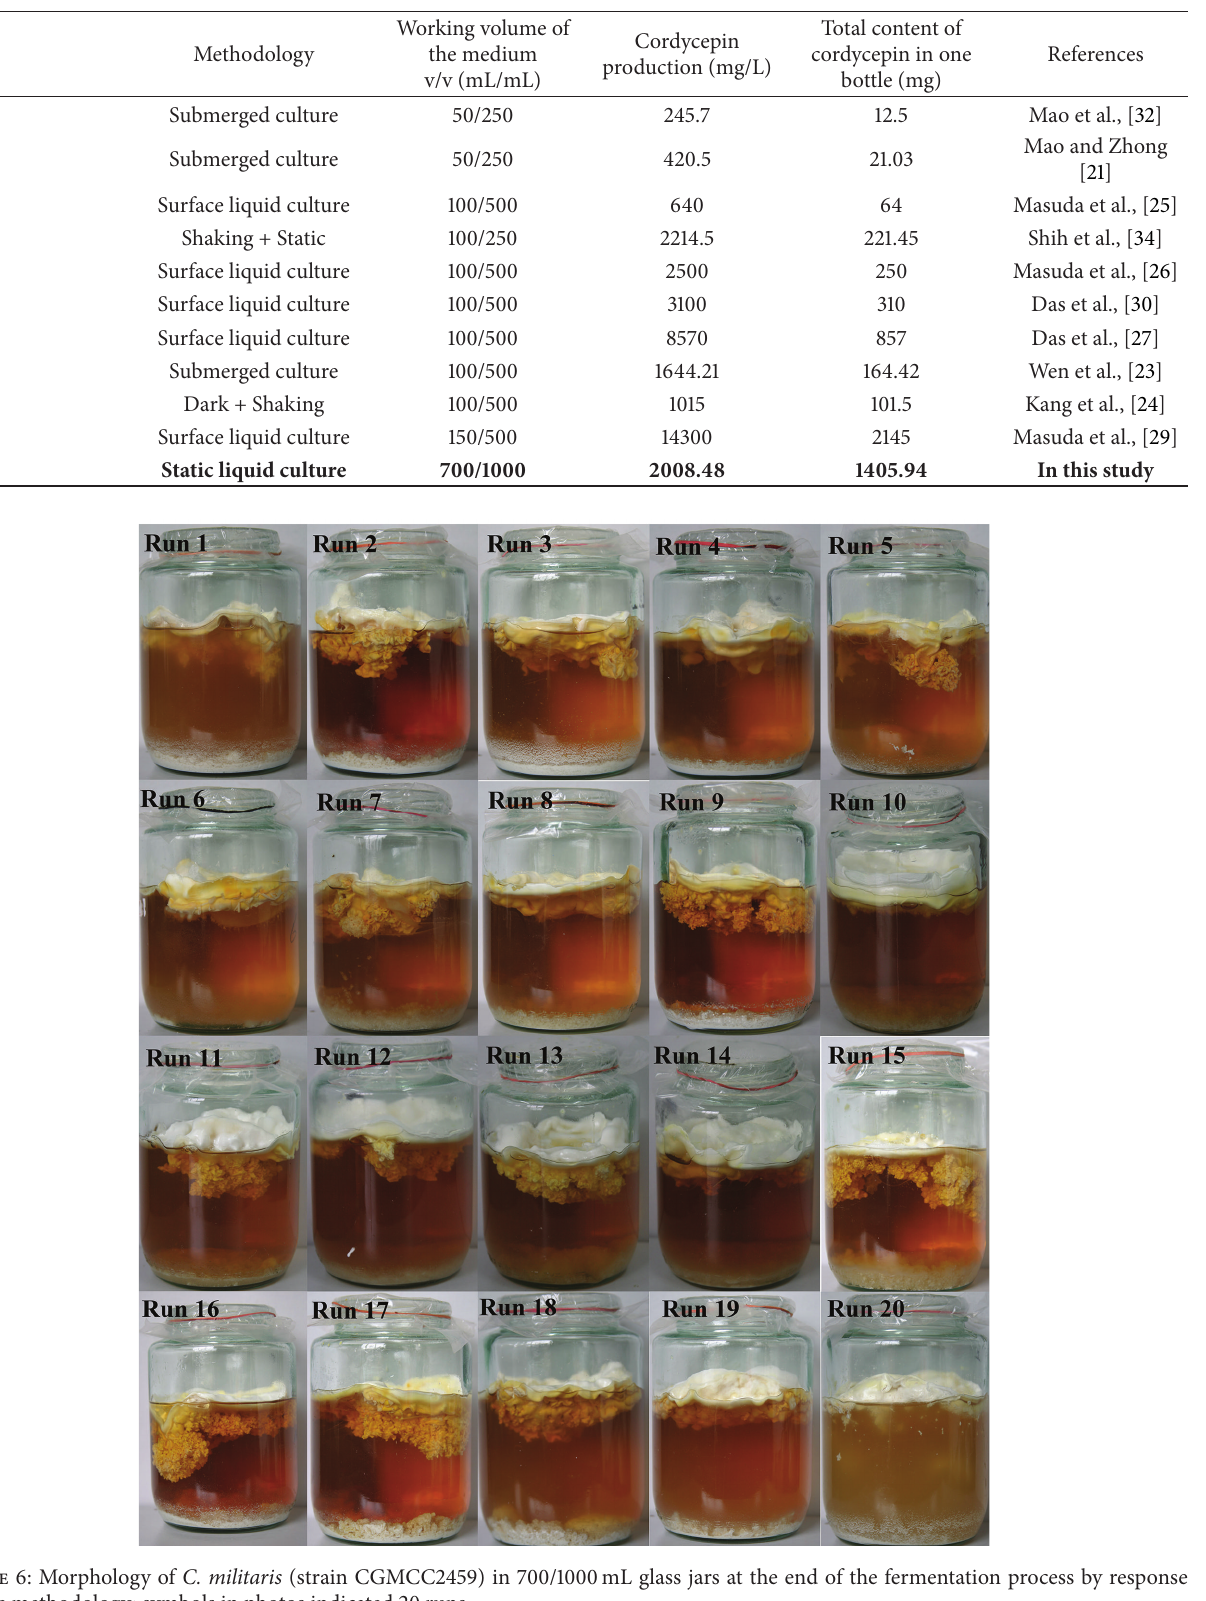
Figure 6: Morphology of C. militaris (strain CGMCC2459) in 700/1000 mL glass jars at the end of the fermentation process by response surface methodology: symbols in photos indicated 20